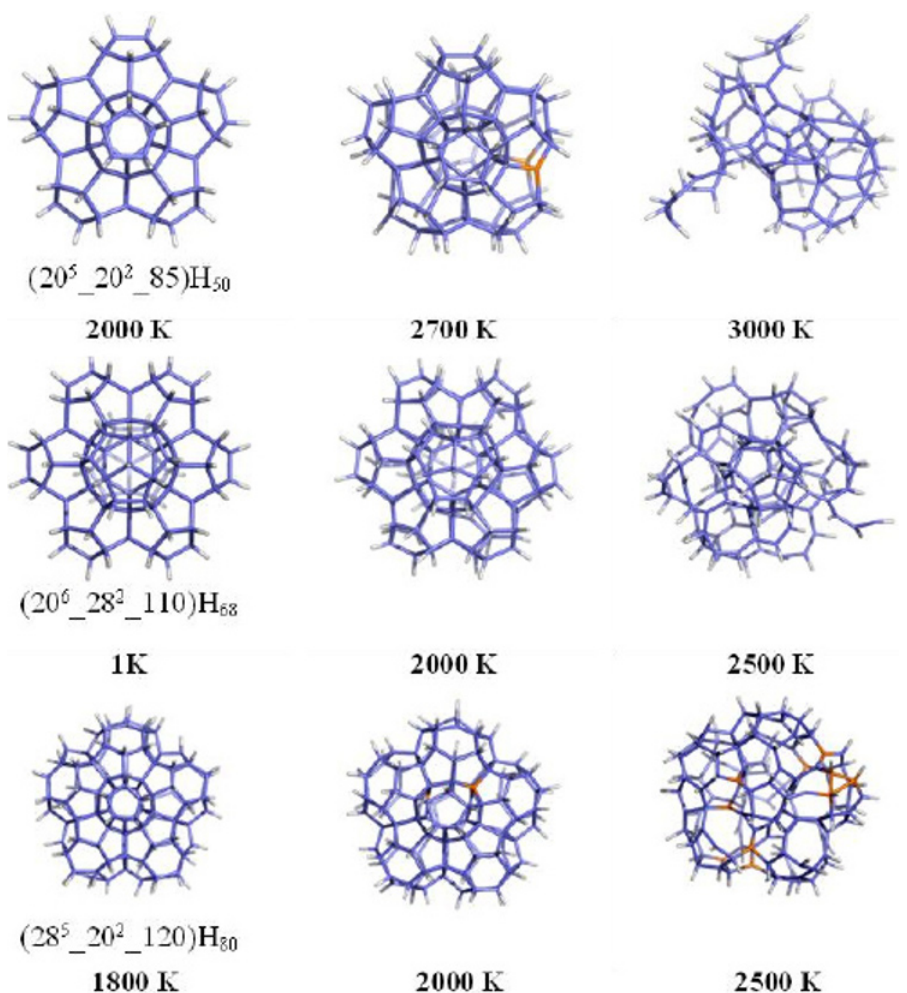
Figure 5. Relaxed structures of (20 5 _20 2 _85)H the broken/formed bonds.